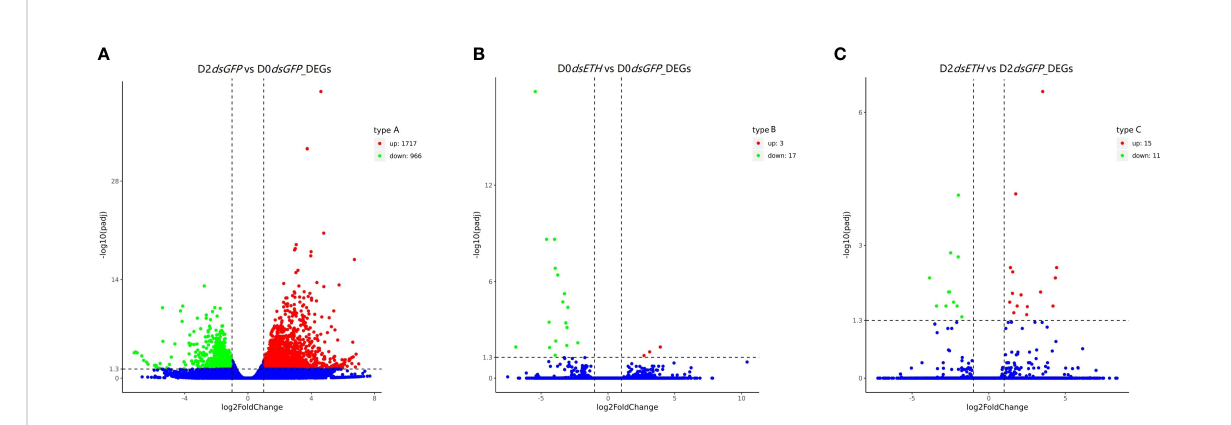
FIGURE 2 Differentially expressed genes (DEGs) in three comparisons of S. paramamosain [corrected P -value <0.05 and |log2(fold change)| >1]. (A) Volcano plot of DEGs in D2dsGFP (Crabs post dsGFP injection at D2 substage) vs. D0dsGFP (Crabs post dsGFP injection at D0 substage). (B) Volcano plot of DEGs in D0dsETH vs. D0dsGFP. (C) Volcano plot of DEGs in D2dsETH vs. D2dsGFP. Red spots represent upregulated genes and green spots indicate downregulated genes. Blue spots represent genes showing no obvious change in the